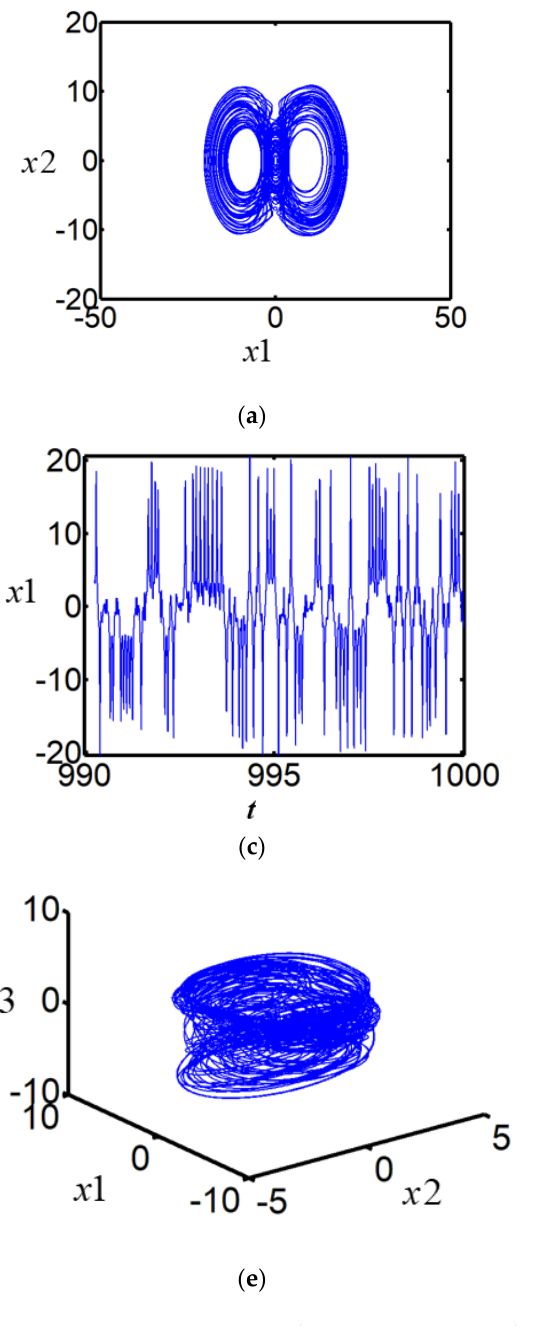
Figure 2. Chaotic motion in nonlinear vibration for the cantilever beam with parameter change: ( a ) phase portrait on the plane ( x 1 , x 2 ) ; ( b ) phase portrait on the plane ( x 3 , x 4 ) ; ( c ) waveform on the plane ( t , x 1 ) ; ( d ) waveform on the plane ( t , x 3 ) ; ( e ) phase portrait in the three-dimensional space ( x 1 , x 2 , x 3 ) ; ( f ) Poincare maps on the plane .